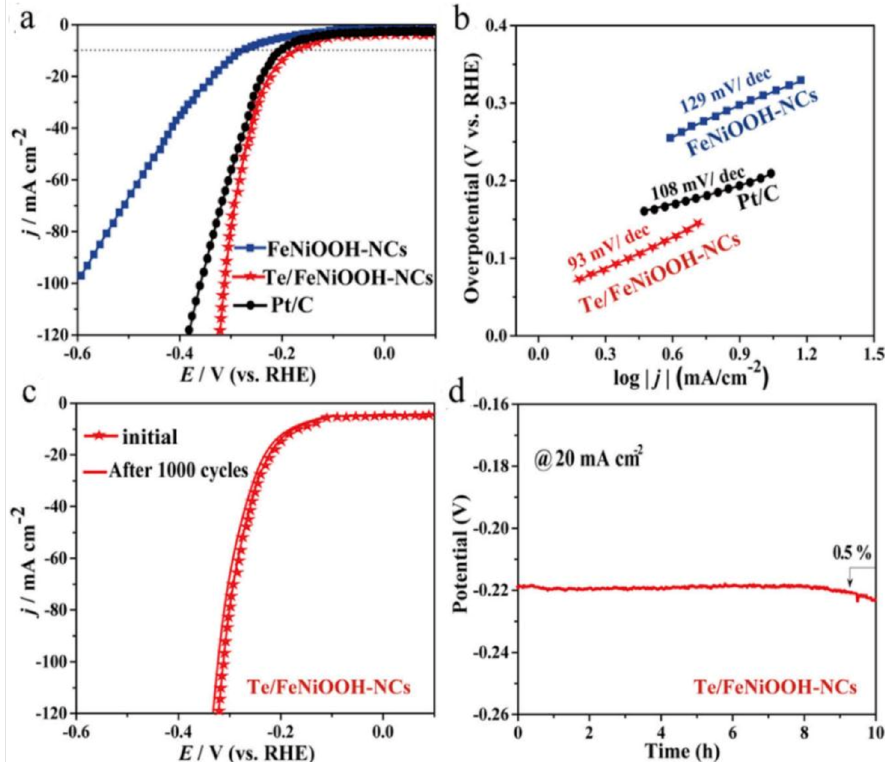
Figure 6. ( a ) LSV curves and ( b ) Tafel plots of Te/FeNiOOH-NCs, FeNiOOH-NCs, and Pt/C electrocatalysts for HER, measured in a 1.0 M KOH solution with 1600 rpm; ( c ) LSV curves before and after 1000 cycles of HER; ( d ) chronopotentiometry (CP) measurements for Te/FeNiOOH-NCs electrocatalyst; these figures were reprinted from